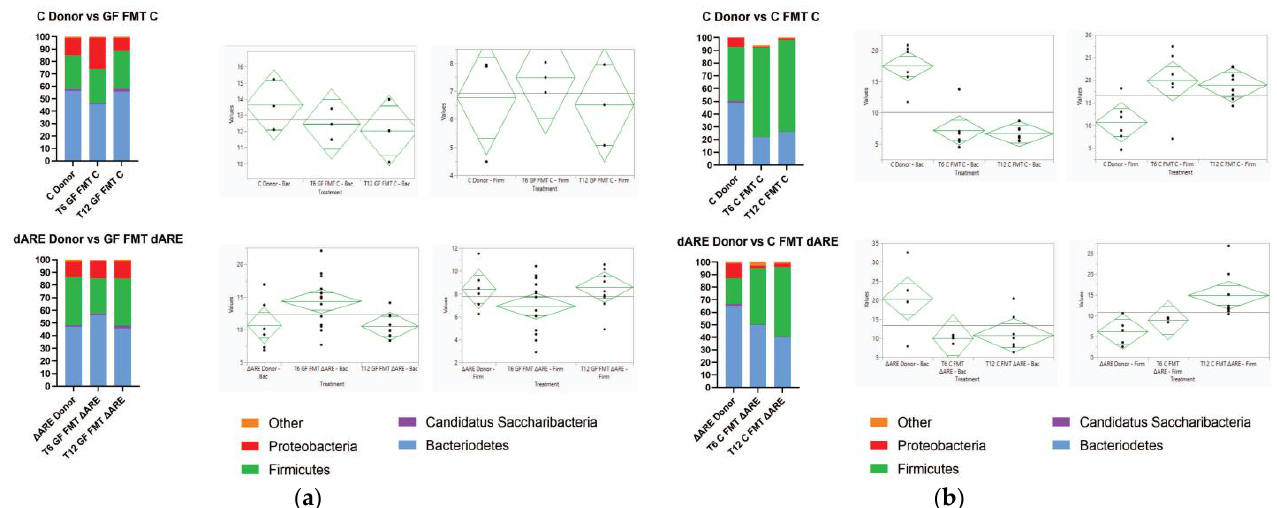
Figure 4. Colonization overtime of the GF and Control colonies after FMT. Colonization at phyla level. Graph Pad Prism was used for generating the stacked bar graphs and the diamond plots were generated by JMP16 software. They represent the confidence interval of each group. The medium line is the mean of the sample group. The Y axes are the CI range for each group. Panel ( a ) Phylogenic results after NGS and HIVE bioinformatics analysis showing the gut microbial profile at the phyla level 6 weeks (T6) and 12 weeks (T12) after GF mice were fecal transplanted from C (top) or TNF ∆ ARE+/ − (bottom). At T6, we observe a reshuffling of the microbiome profile in both GF mice FMT with C donors ( n = 3) and GF mice FMT with TNF ∆ ARE+/ − donors ( n = 14). At T12 weeks, the microbiome profile of recipient mice is completely normalized relative to their donors, both in GF mice FMT with control donors ( n = 3) and with TNF ∆ ARE+/ − donors ( n = 10). ANOVA statistical analysis shows no significant difference between T12 mice and their respective donors ( p > 0.05), for both the Bacteroidetes and Firmicutes phyla, for GF mice FMT with either C or TNF ∆ ARE+/ − . Panel ( b ) Phylogenic results showing healthy control mice FMT with C (top) or TNF ∆ ARE+/ − (bottom) donors, 6 weeks (T6) and 12 weeks (T12) after fecal transplant. At T6, we observe a reshuffling of the microbiome profile in both C FMT with C donors ( n = 6) or C FMT with TNF ∆ ARE+/ − donors ( n = 4). By T12, the microbiome profile of the recipient mice is significatively different from the donor, for both C mice FMT with C donors ( n = 8) and C mice FMT with TNF ∆ ARE+/ − donors ( n = 8). ANOVA statistical analysis shows a significant difference at T12 between C Donors and C mice FMT with C donors, for both the Bacteroidetes phyla ( p < 0.0001) and Firmicutes phyla ( p < 0.0001). ANOVA statistical analysis shows a significant difference at T12 between TNF ∆ ARE+/ − donors and C mice FMT with TNF ∆ ARE+/ − donors, for both the Bacteroidetes phyla ( p = 0.0121) and Firmicutes phyla ( p =